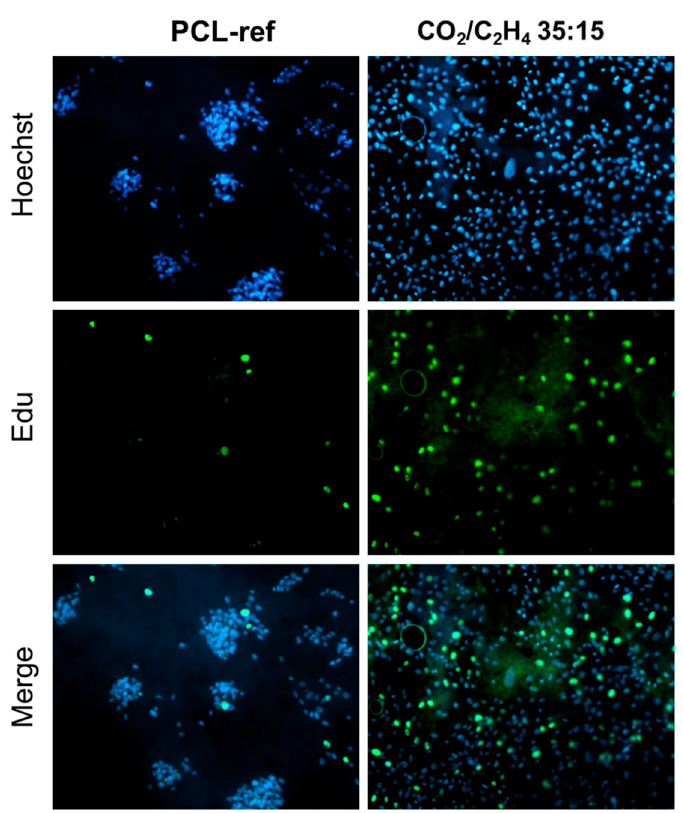
Figure 11. Proliferation and viability of human MSCs on the surface of PCL-ref and nanofibers coated with Ar/CO 2 /C 2 H 4 plasma polymer at a CO 2 /C 2 H 4 = 35:15. The cell nucleus is stained with DNA binding fluorescent dye Hoechst 33342 (blue), the proliferating cells are stained with EdUAlexa Fluor™ 488 (green). All images are shown at ×20 magnification.